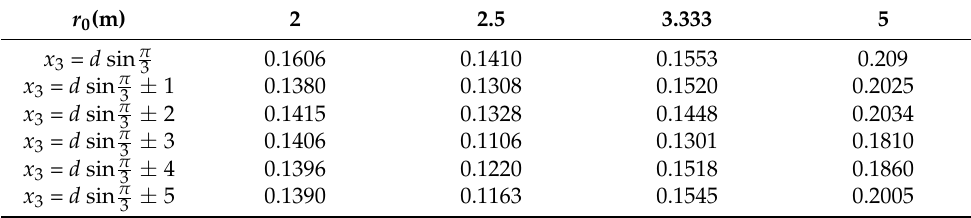
Table 2. Error ( ε / d ) analysis for different triangle shapes (“ x ” coordinate of AN 3